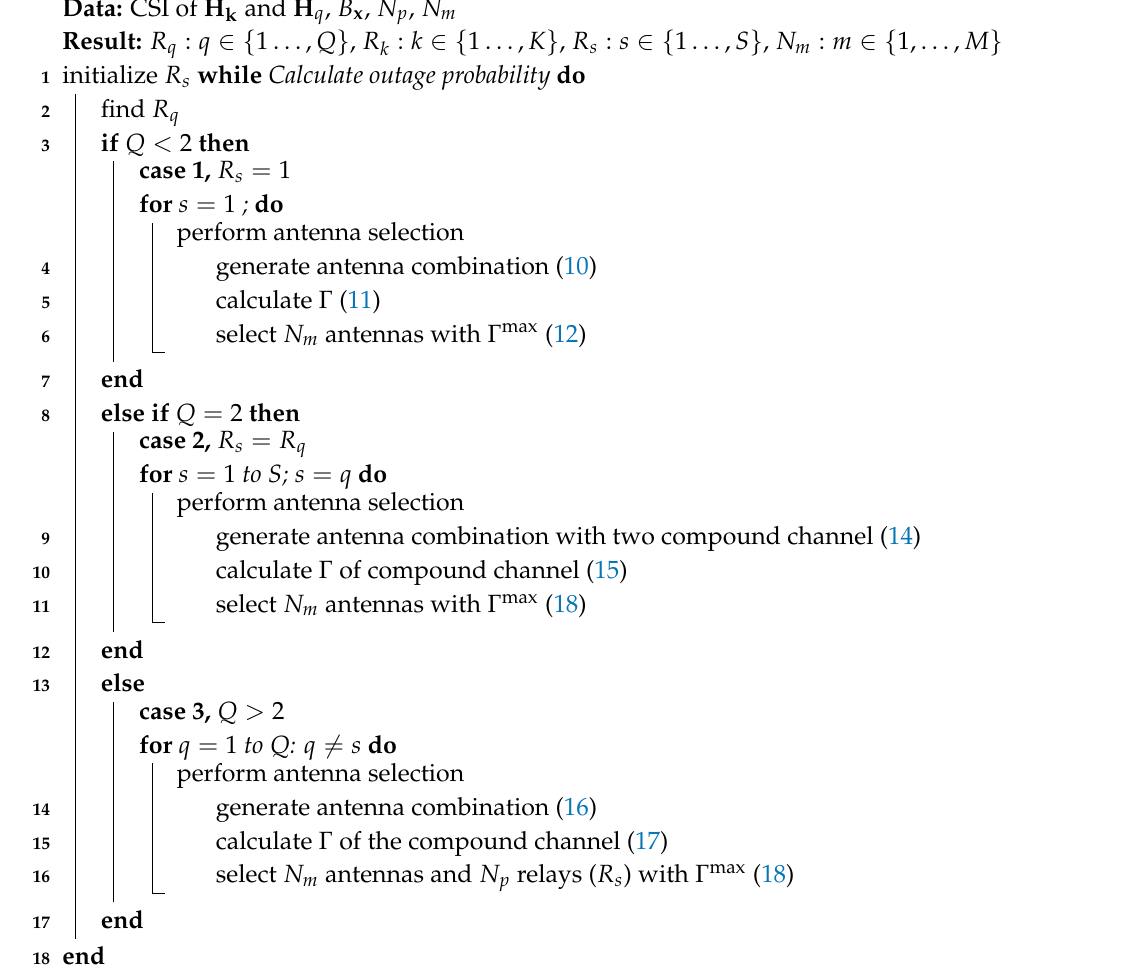
Algorithm 1: Algorithm for proposed scheme Data: CSI of H k and H q , B x , N p , N